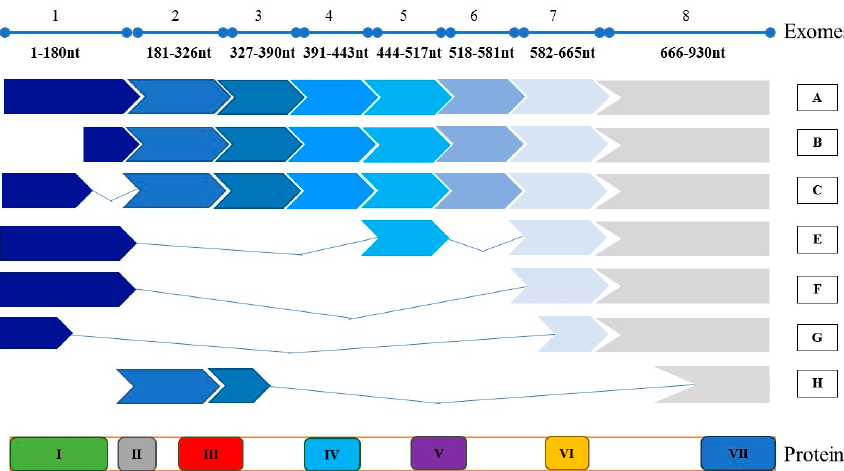
Figure 1. Illustrations of the AGR2 gene and its corresponding protein structure, as well as the detected splice variants. A-H represent AGR2 splice variants. Functional domains for AGR2 protein are shown as: (I) 1-20aa CHPS, directs the AGR2 protein to the ER and contains block of hydrophobic amino acid residues; (II) 20-21aa Ala-Lys, is a leader sequence; (III) 21-45aa, is important for the extracellular secretion; (IV) 60-64aa, is required for dimerization; (V) CXXS motif, interacts with intermediates in redox reactions during folding and retrograde transport in the secretory pathway; (VI) A peptide binding lobe that is important for protein–protein interactions; and (VII) KETL, works to different compartments in the